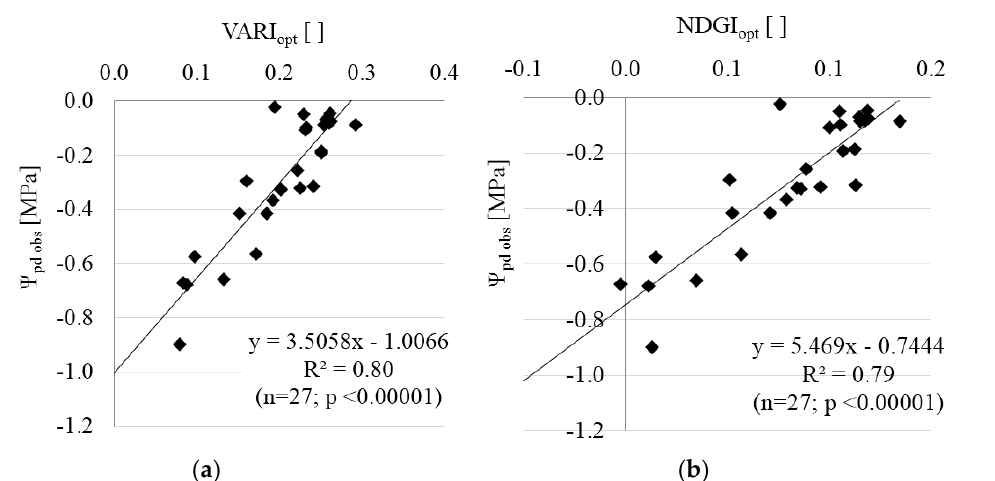
Figure 6. Linear regression between the observed predawn leaf water potential ( Ψ pd obs ) and the vegetation indices VARI ( a ) and NDGI ( b ) computed with the best combination of wavelengths using the parameterization dataset (block